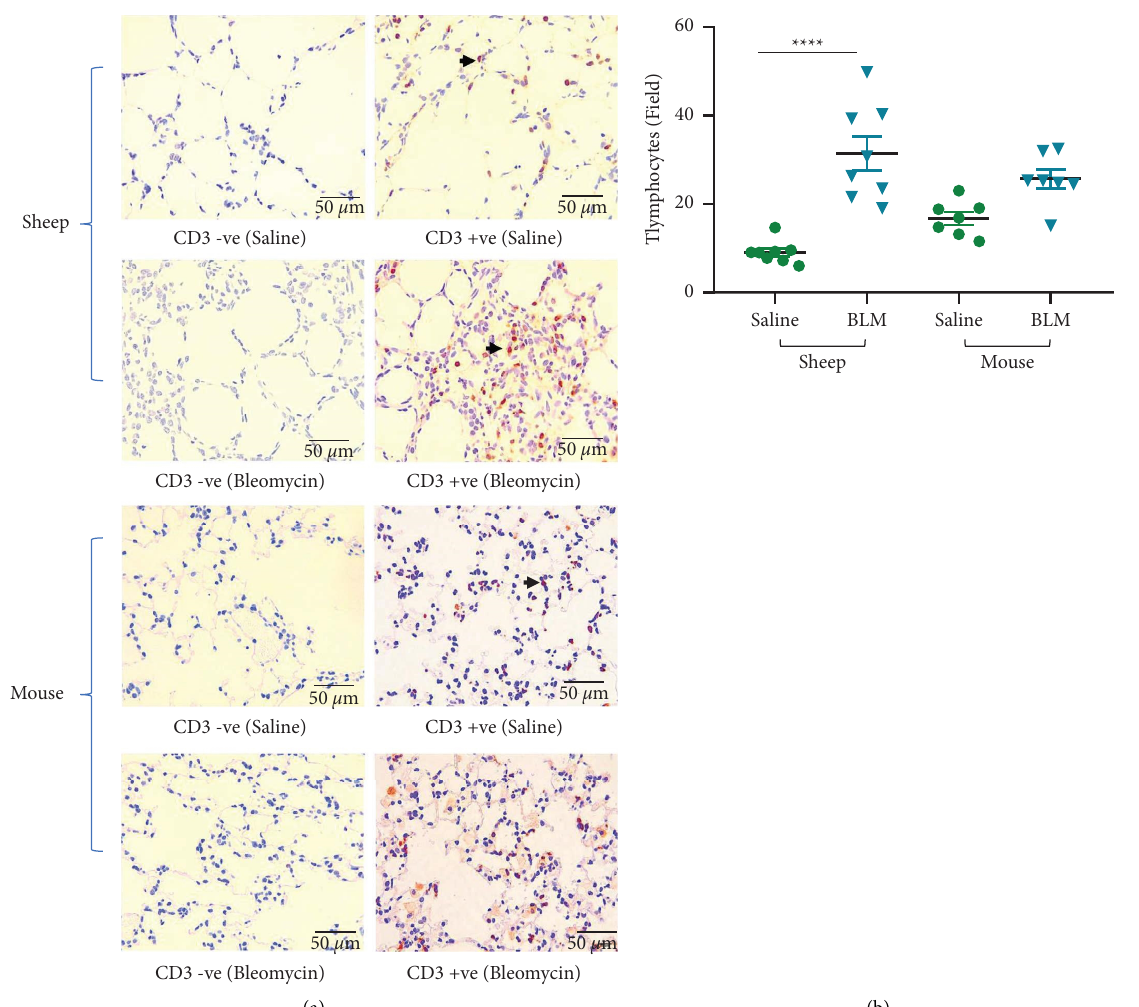
Figure 5: Immunohistochemical staining of T lymphocytes (CD-3 +ve) in sheep and mouse lung tissues (a). Arrows indicate examples of T lymphocytes. Te graph represents the T-cell infltration levels between saline-infused and bleomycin-infused lung segments of sheep ( n � 8) and lung tissues from saline control ( n � 7) and bleomycin-treated mice ( n � 7) (b). Twenty representative nonoverlapping felds in the lung parenchyma were captured under × 40 magnifcation for analysis. Each bar represents the mean ± standard error of the mean. Signifcance was determined by one-way ANOVA and Tukey’s post-hoc test to make multiple comparisons test between the groups. ∗∗∗∗ p < 0 .